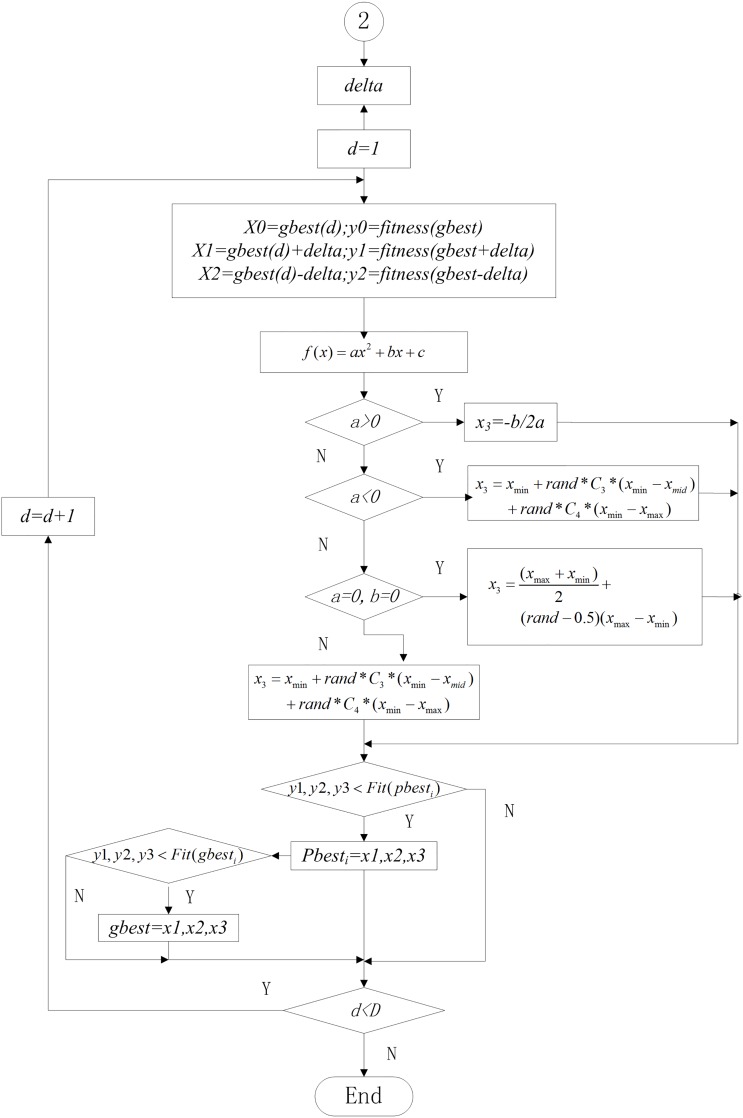
The flowchart of LSLI.